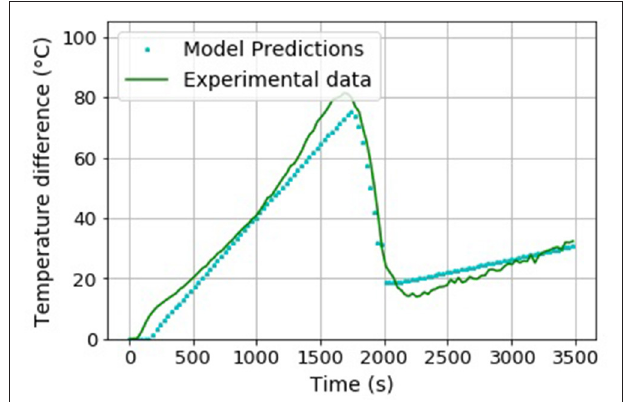
FIGURE 14 | Experimental and numerical results of the temperature at the top